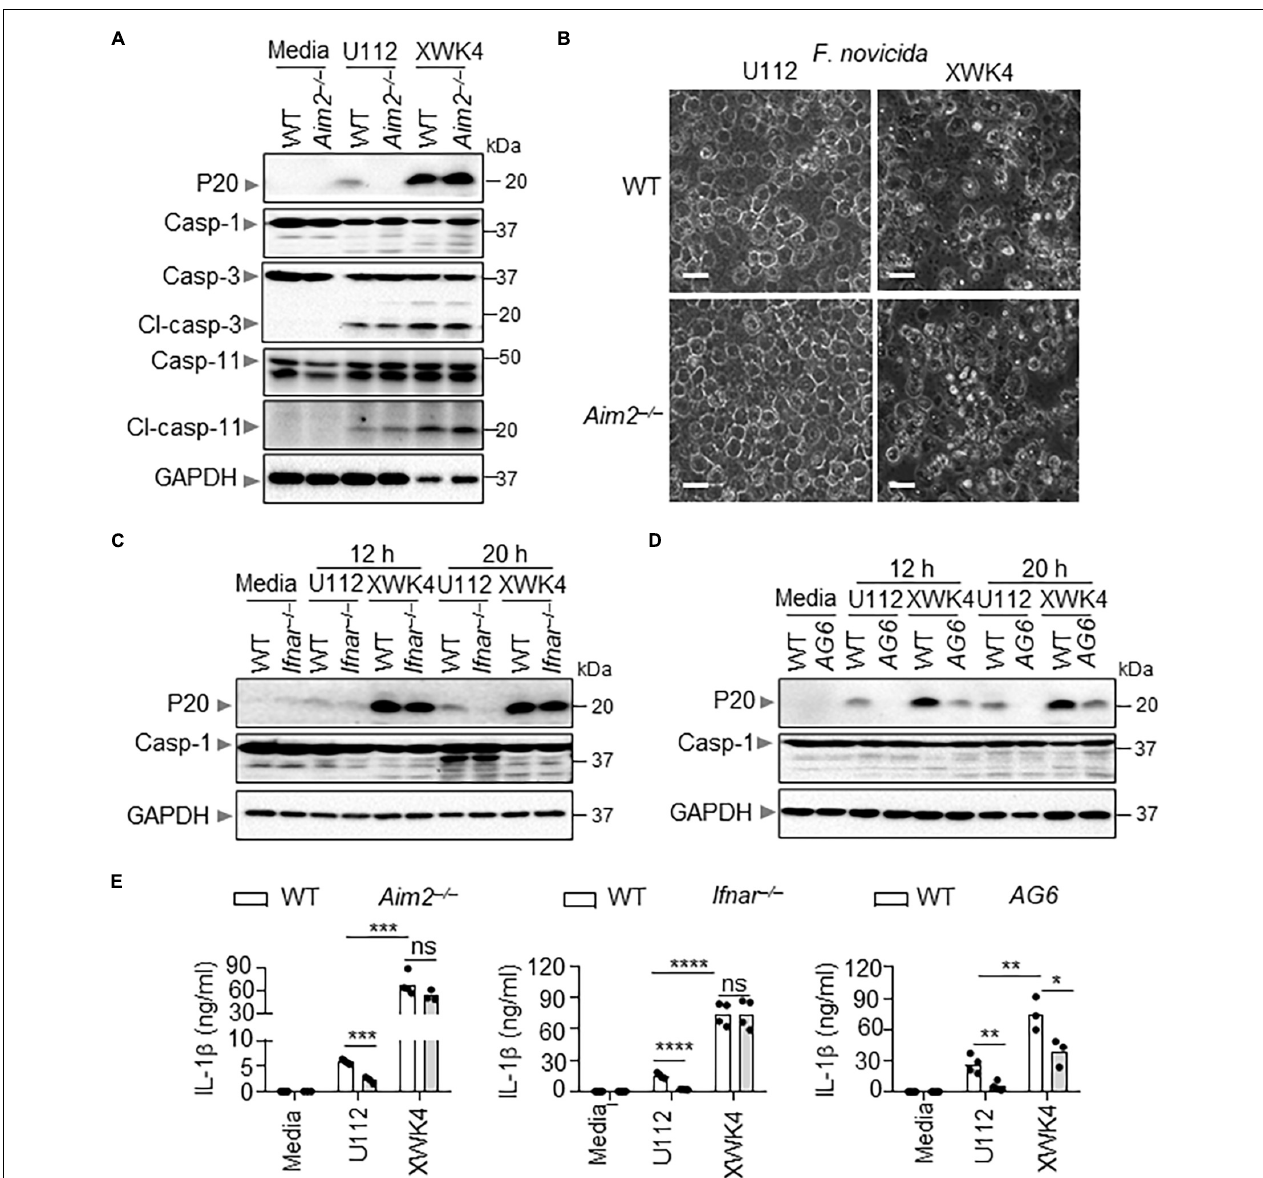
FIGURE 2 | Compared with U112, XWK4 triggers higher intensity of inflammasome activation. (A) Immunoblot analysis of caspase-1 (cleaved, P20), caspase-3 (cleaved, Cl-casp-3), and caspase-11 (cleaved, Cl-casp-11) in WT and Aim2 − / − BMDMs with and without infection of U112 and XWK4 (200 MOIs) for 20 h. (B) Cell death analysis of WT and Aim2 − / − BMDMs infected with U112 and XWK4 (200 MOIs) for 14 h. Scale bars: 20 µ m. (C) Immunoblot analysis of caspase-1 (cleaved, P20) in WT and Ifnar − / − BMDMs with and without infection of U112 and XWK4 (200 MOIs) for indicated times. (D) Immunoblot analysis of caspase-1 (cleaved, P20) in WT and AG6 BMDMs with and without infection of U112 and XWK4 (200 MOIs) for indicated times. (E) Analysis of IL-1 β release in WT and knockout BMDMs as indicated infected with U112 and XWK4 (200 MOIs) for 20 h. * P < 0.05; ** P < 0.01; *** P < 0.001; **** P < 0.0001; ns, not significant (two-sided Student’s t -test without multiple comparisons correction). Data are representative of three independent